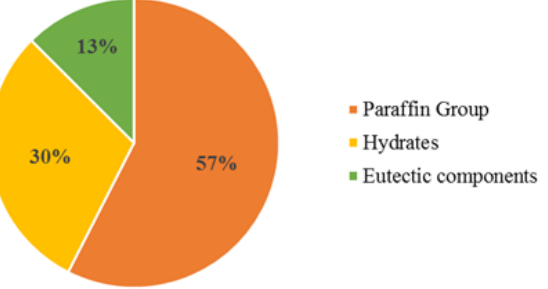
Figure 5. Diagram of PCM classification [17].